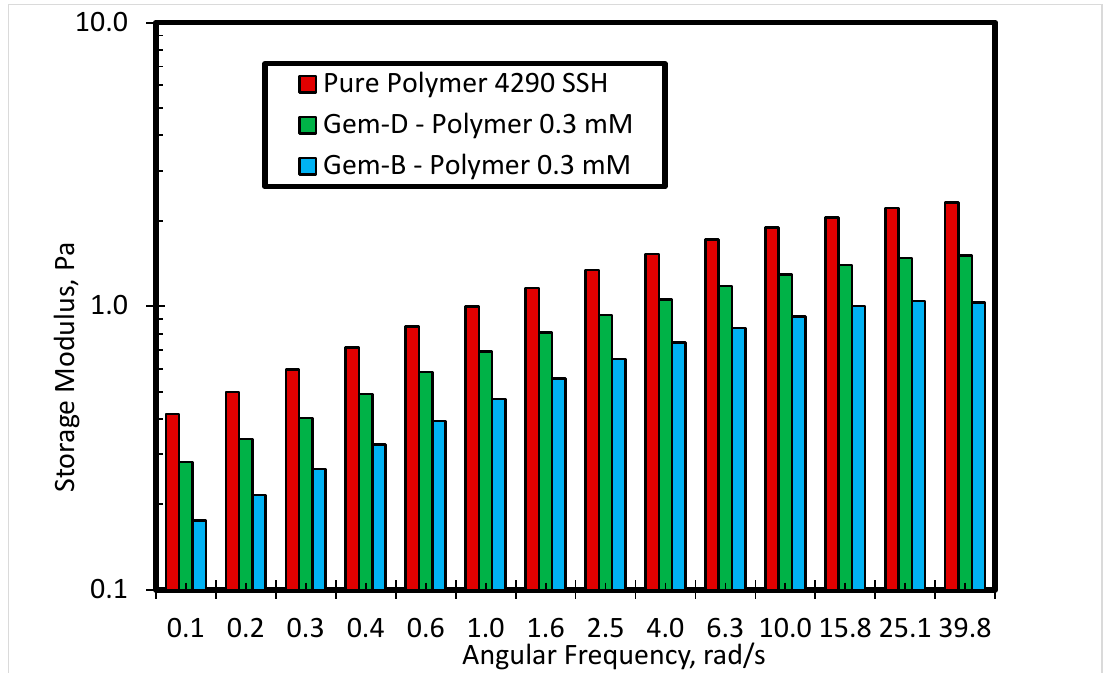
Figure 11. Storage modulus of 4290 SSH polymer with Gem-D and Gem-B at 0.3 mM concentration.